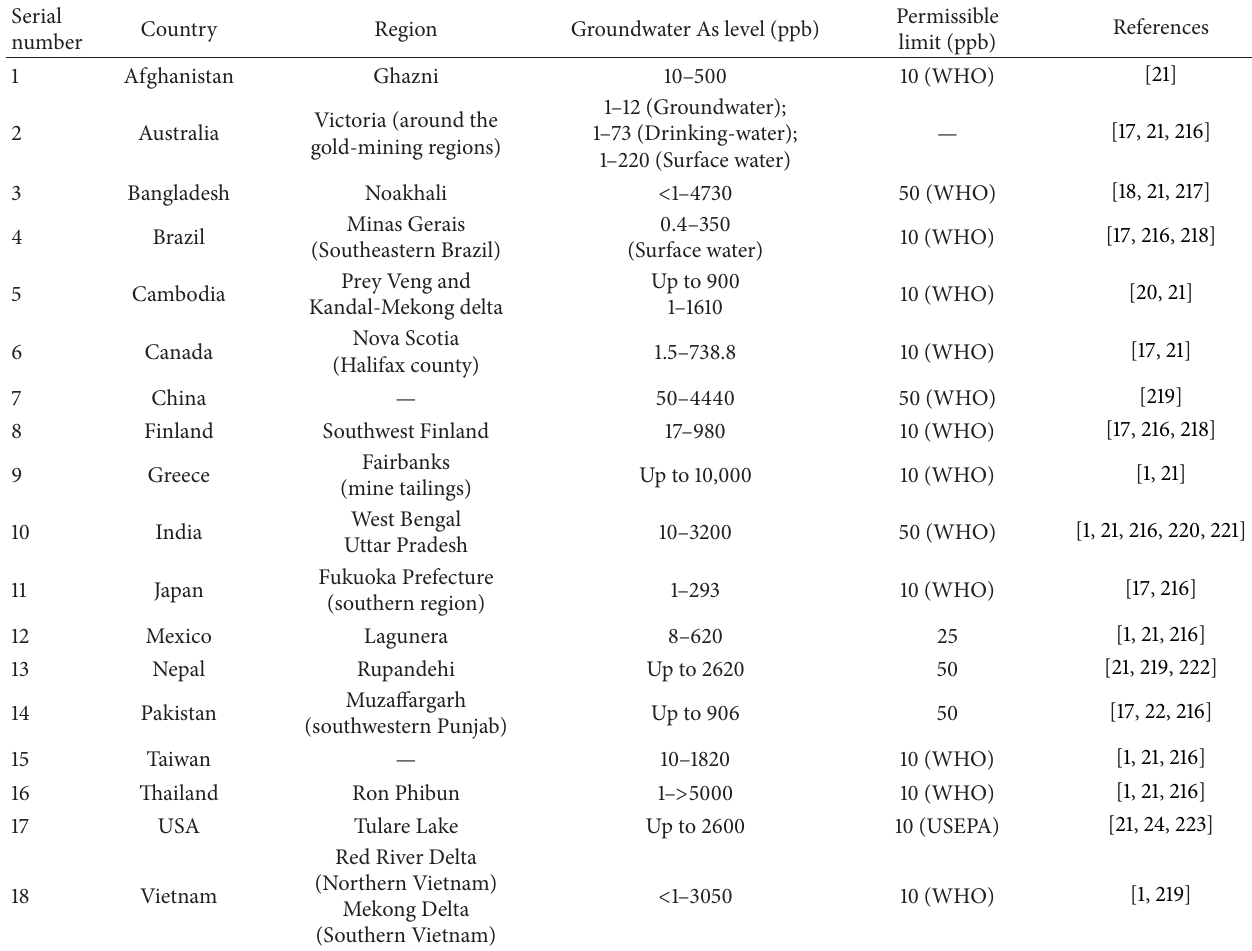
Table 1: Status of As contamination in natural groundwater in various